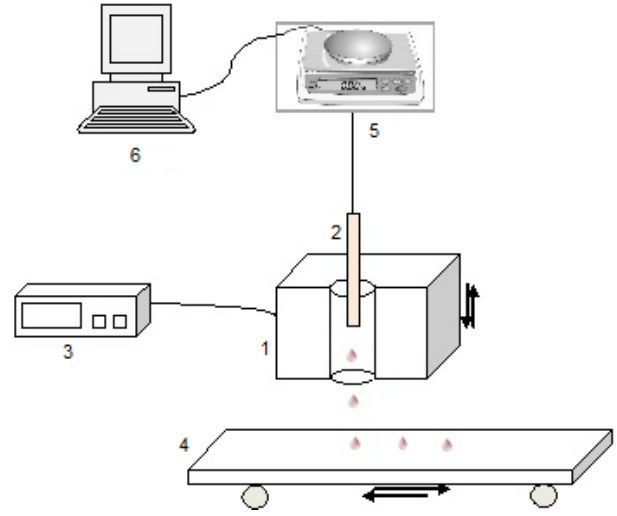
Figure 2. A schematic sketch of the experimental set ‐ up to study the melt ‐ drip phenomenon in non ‐ flaming conditions: 1—electric mobile furnace; 2—tested polymer sample; 3—adjustable temperature controller; 4—conveyer belt with aluminium foil; 5—balance; 6—computer (used by [7]).